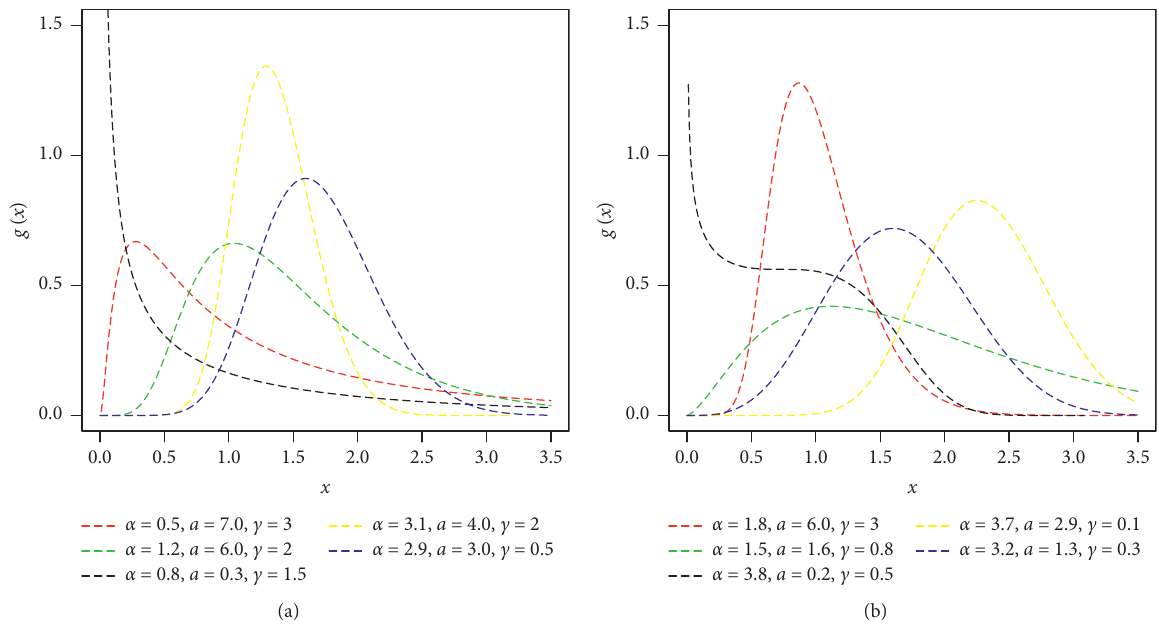
Figure 1: Different plots for the pdf of the ASE-W distribution for selected values of its parameters.